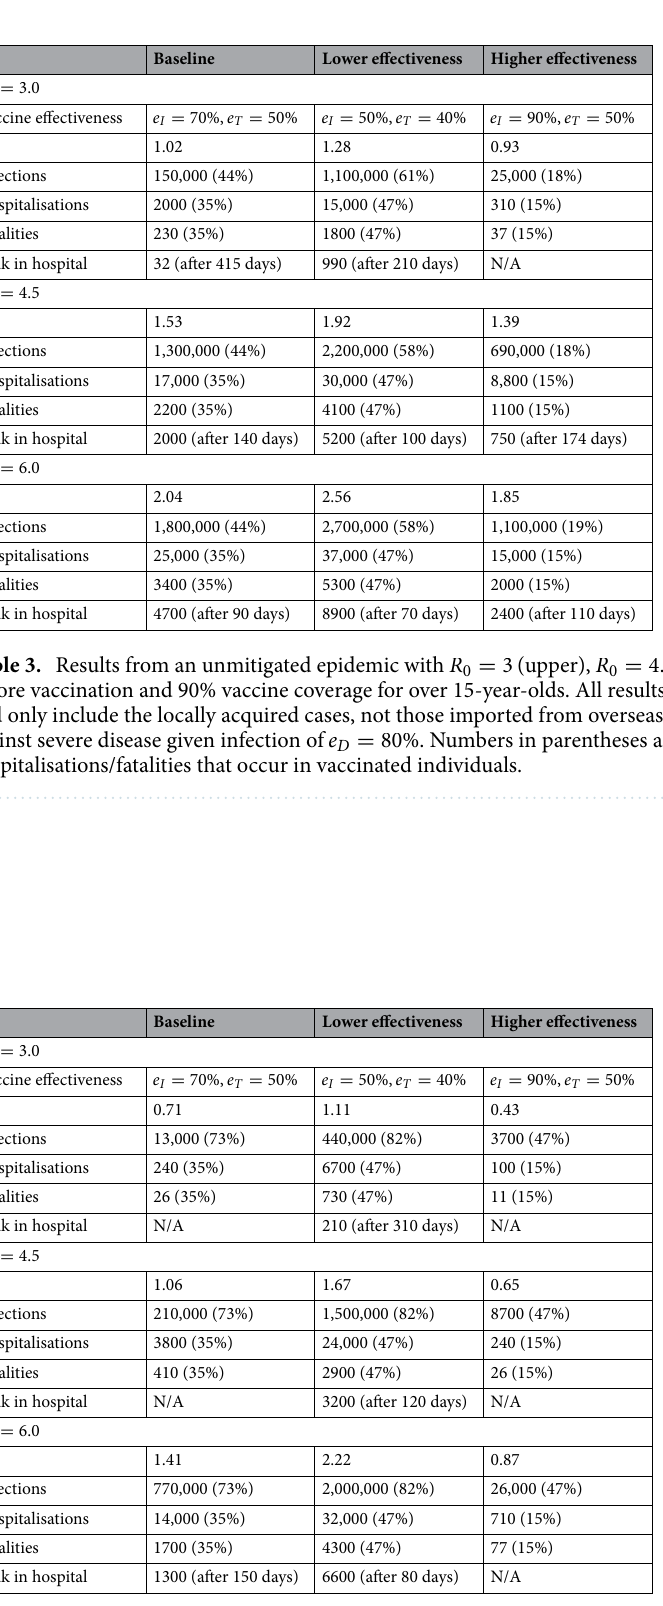
Table 4. Results from an unmitigated epidemic with R 0 = 3 (upper), R 0 = 4.5 (middle) and R 0 = 6 (lower) before vaccination and 90% vaccine coverage for the entire population (including children). All results given to 2 significant figures and do not include imported cases, only the resulting community transmission cases. All scenarios assume protection against severe disease given infection of e D = 80% . Numbers in parentheses are the percentage of infections/hospitalisations/fatalities that occur in vaccinated individuals.